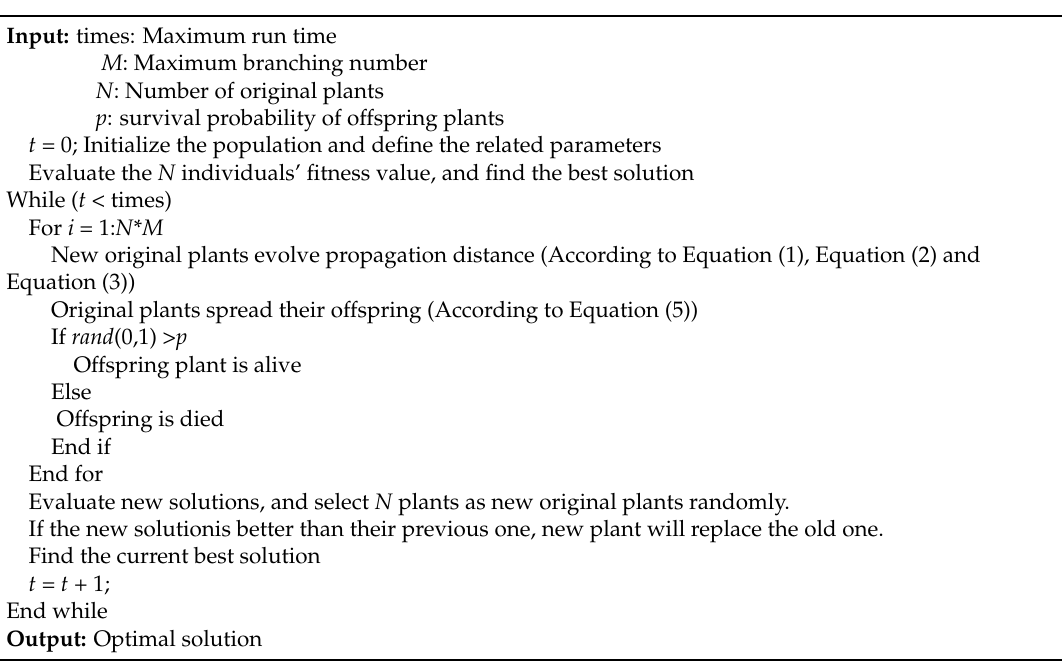
Table 1. Pseudo code of artificial flora algorithm.